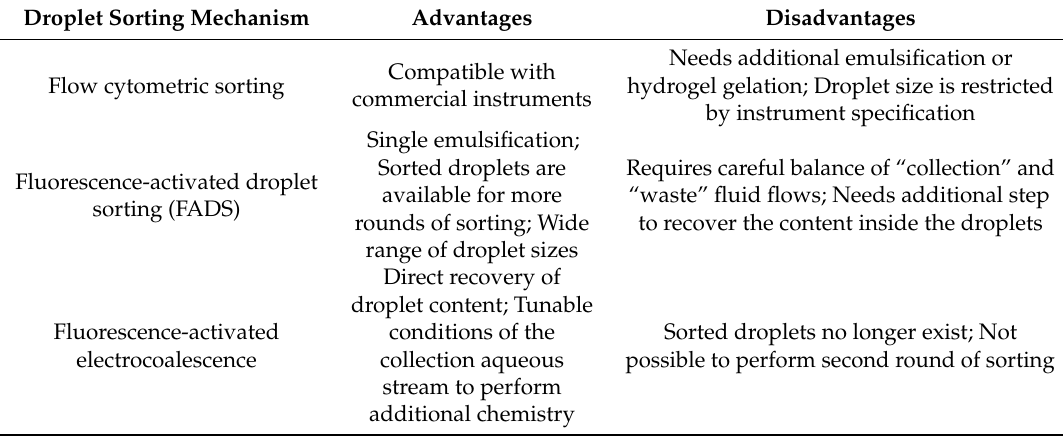
Table 2. Advantages and disadvantages of existing droplet-based HTS